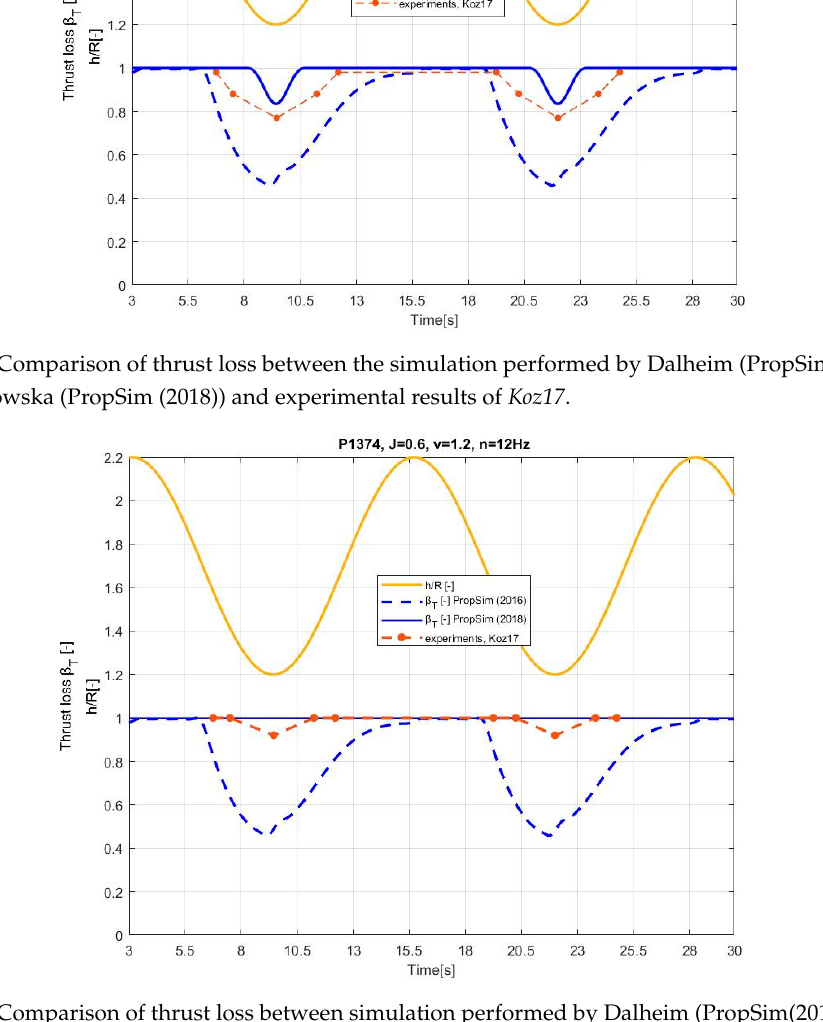
Figure 5. Comparison of thrust loss between simulation performed by Dalheim (PropSim(2016)) and Kozlowska (PropSim (2018)) and experimental results of Koz17.